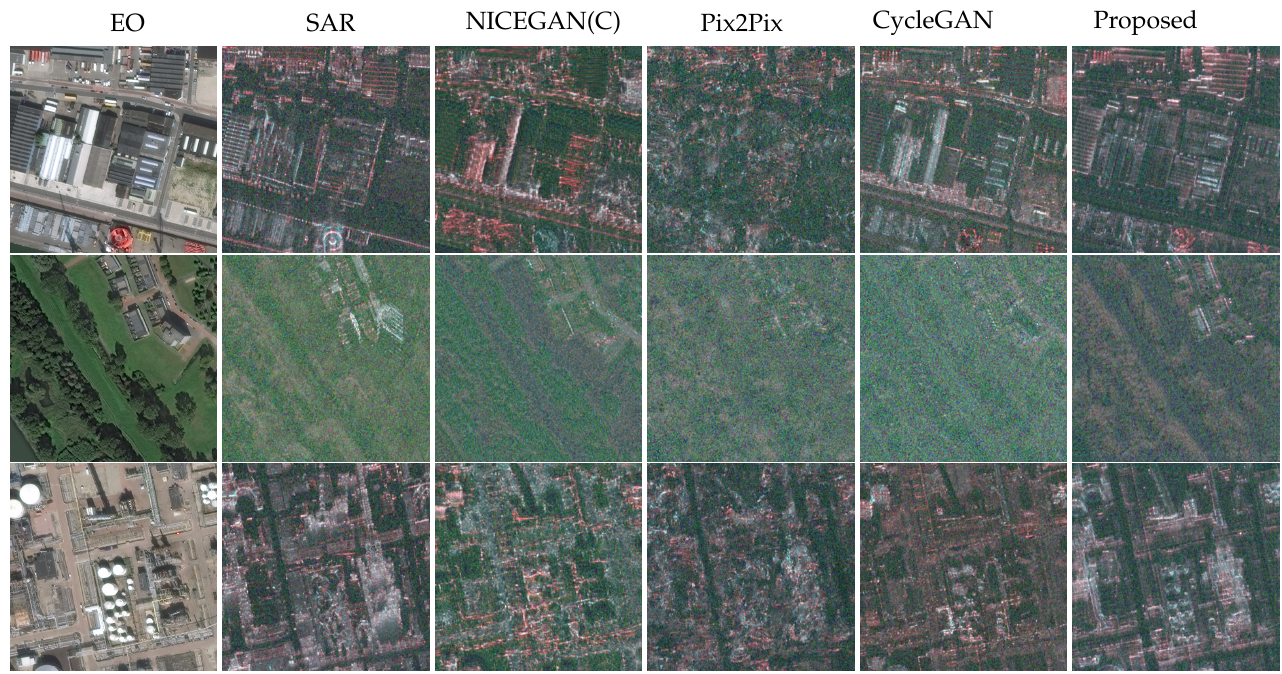
Figure 9. Visual samples of different methods for the E2S translation task on the SN6-SAROPT dataset.